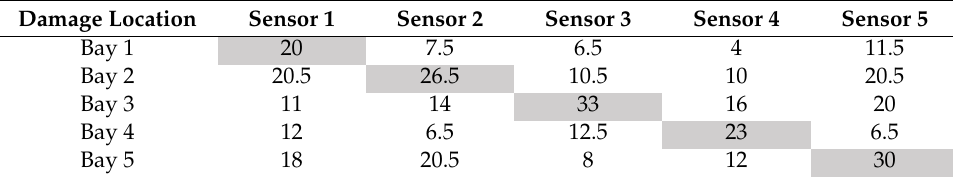
Table 3. Detectability in decibels for the EC damage analysis (DV values).